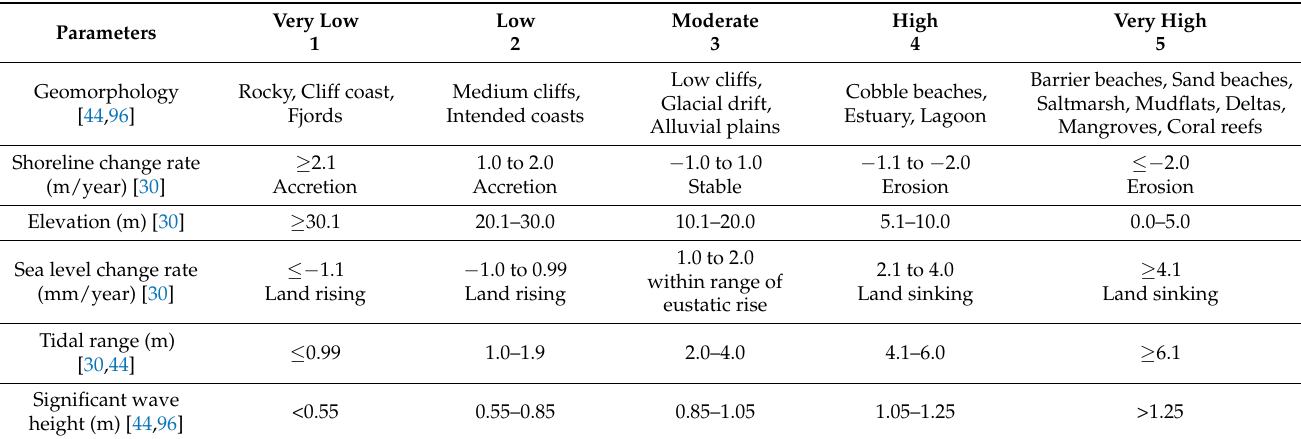
Table 2. Risk rating assigned for different